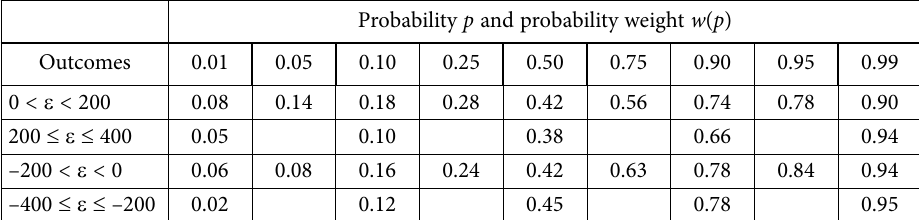
Table 3. Relationship of probability p and psychological probability probability w ( p ) Probability p and probability weight w ( p